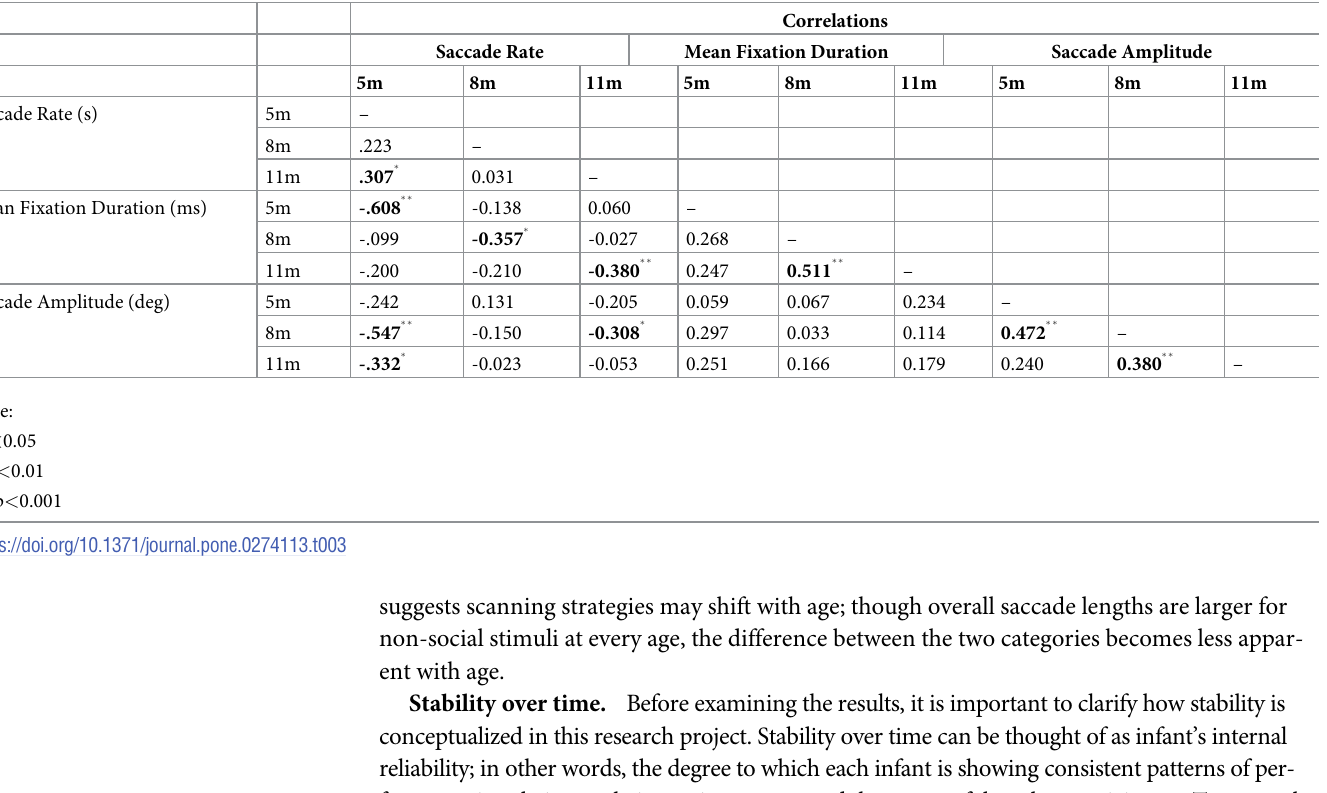
Table 3. Experiment 1 correlation table for all scanning metrics across 5-, 8-, and 11-month longitudinal visits. Sample sizes for comparison groups were as follows: 5 and 8 months ( n = 30), 5 and 11 months ( n = 52), and 8 and 11 months ( n = 49). Significant correlations noted in